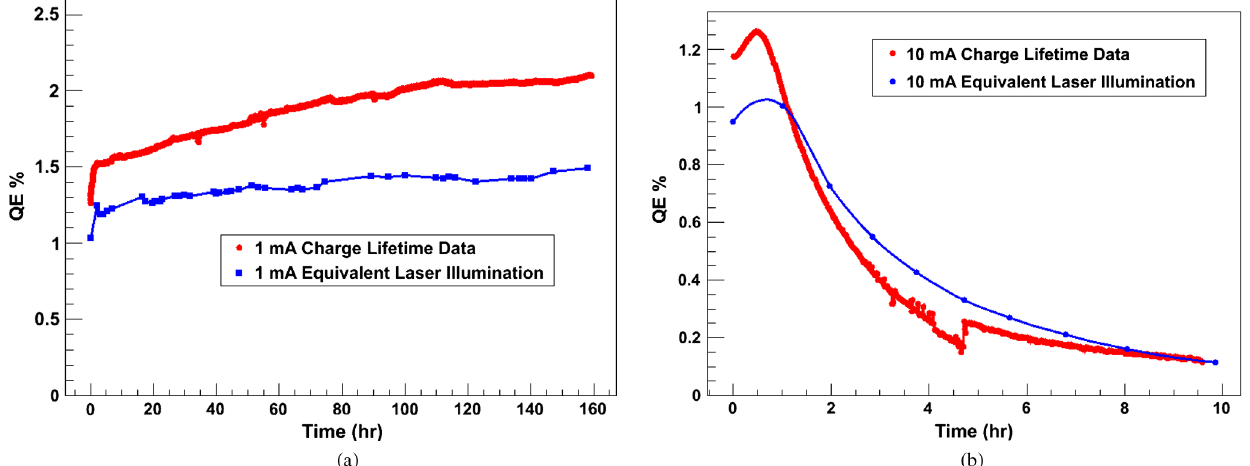
FIG. 13. QE evolution at (a) 1 mA and (b) 10 mA equivalent laser power. Continuous lines represent QE measured while delivering beam at 100 kVand data points represent QE measured at low voltage during ‘‘laser-heating’’ runs, with no high voltage and no beam delivered to the Faraday cup. Data points were connected to aid the